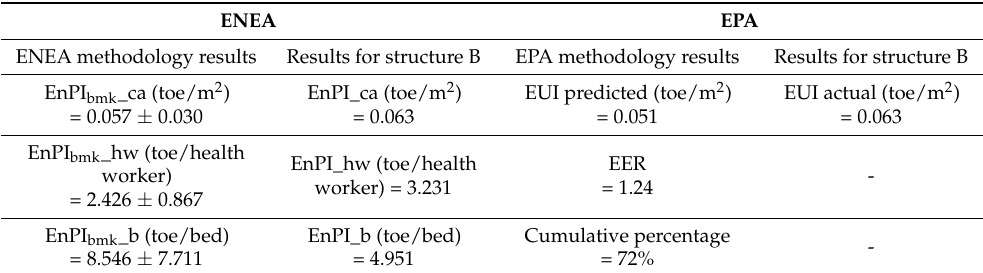
Table 8. Results of the comparison between the ENEA methodology and EPA methodology for structure